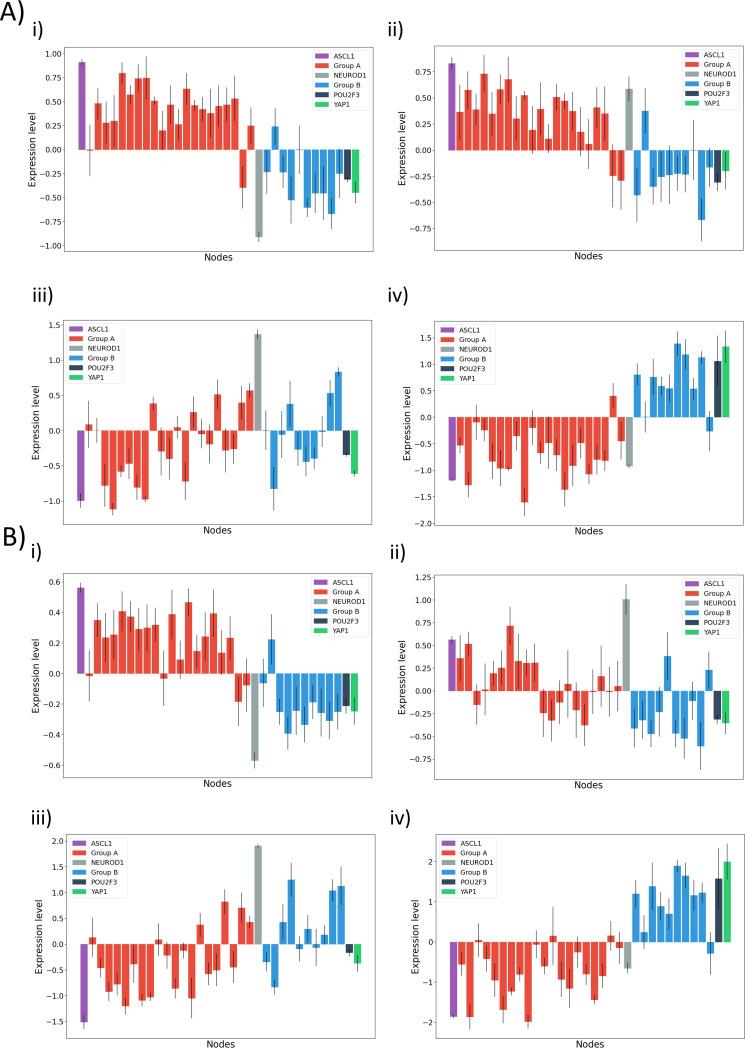
Gene expression of nodes involved in graph after clustering: Red bars indicate a node belonging to group A, and blue bar indicates belonging to group B.ASCL1, NEUROD1, YAP1, and POU2F3 have different colors for better comparison (A) (i–iv) Hierarchical clustering of CCLE dataset across ASCL1 and NEUROD1, with individual panels depicting individual clusters: (i) A+/N−, (ii) A+/N+, (iii) A−/N+, (iv) A−/N−. and (B) (i–iv) K-means clustering of GSE73160 dataset ASCL1 and NEUROD1, with individual panels depicting individual clusters: (i) A+/N−, (ii) A+/N+, (iii) A−/N+, (iv) A−/N−.